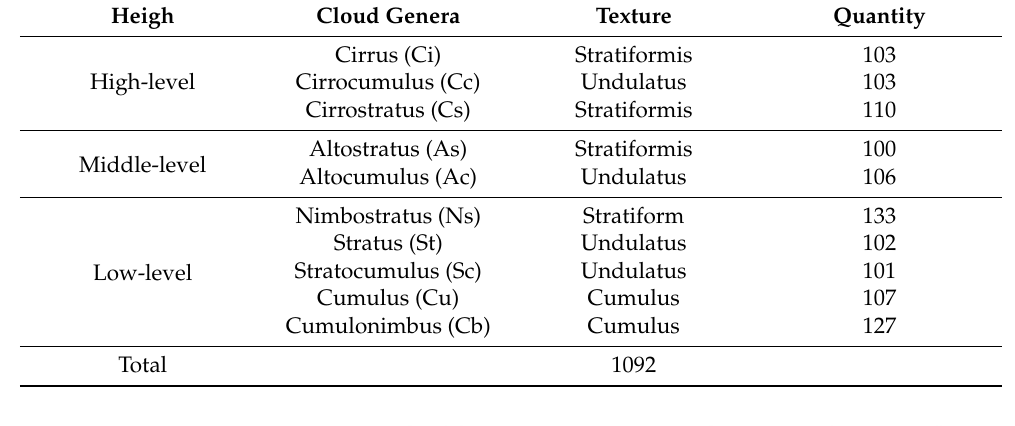
Table 1. Classification and quantity of cloud genera.